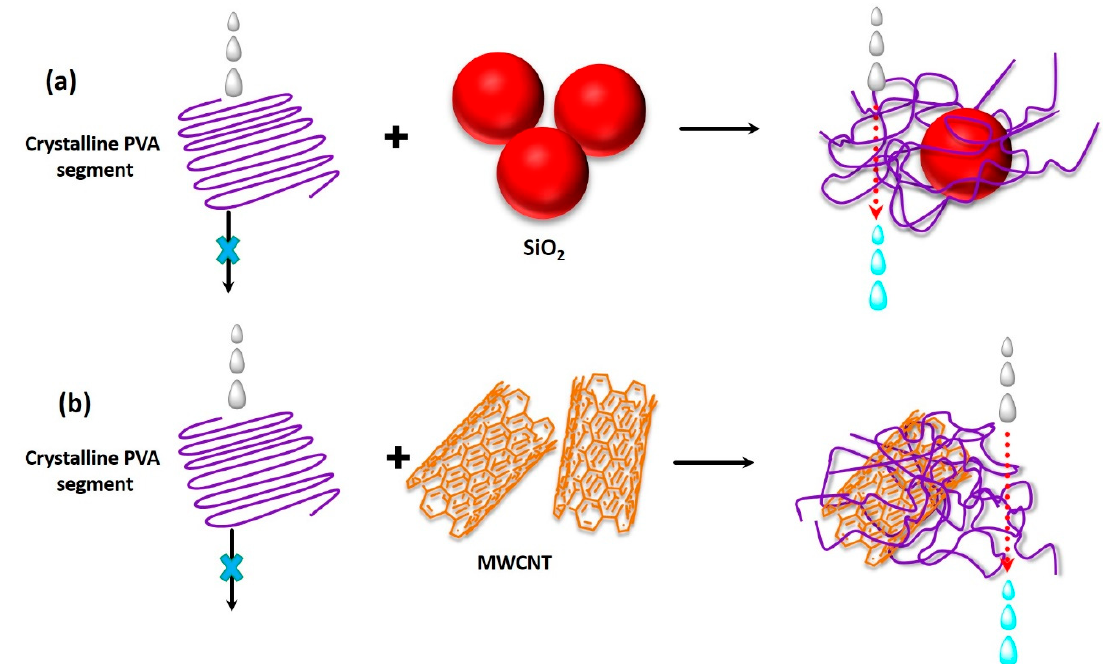
Figure 18. Disruption of polymer chain packing facilitates increased flux in NCP membrane containing ( a ) SiO 2 and ( b ) MWCNT.